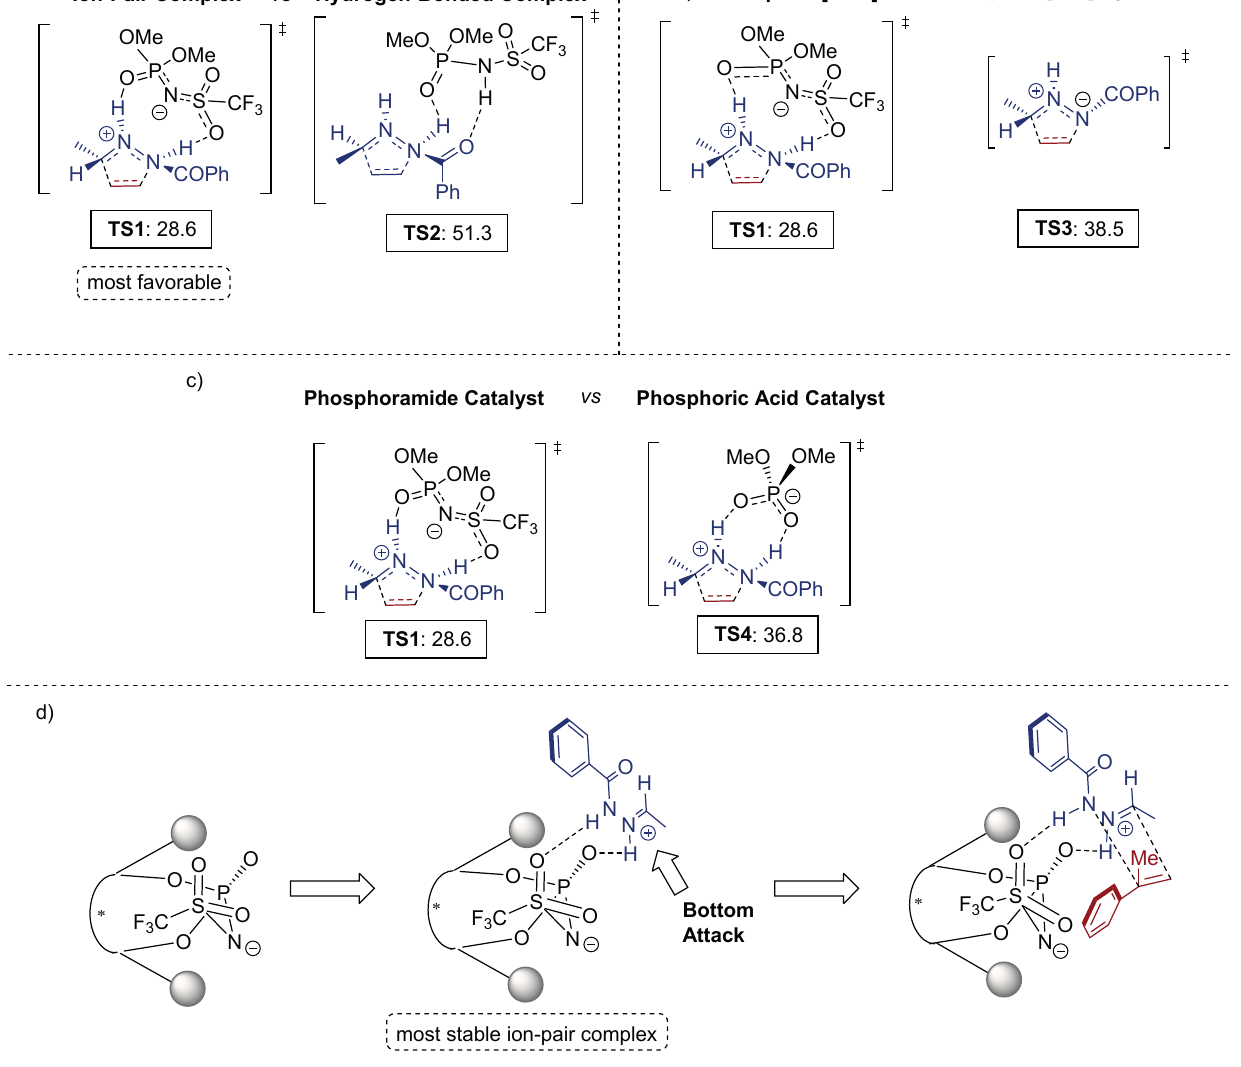
Figure 11. Mechanistic studies at DFT Level M06-2X/6-311+G(d,p) (energies in frames in Δ G = kcal/mol) using the conductor-like polarizable continuum model (CPCM) solvent model: A comparison of ( a ) two possible activation modes; ( b ) two possible reaction pathways; ( c ) phosphoramide and phosphoric acid catalyzed [3+2] cycloaddition; ( d ) activation and transition states for the enantioselective N -triflyl phosphoramide-catalyzed [3 + +2]